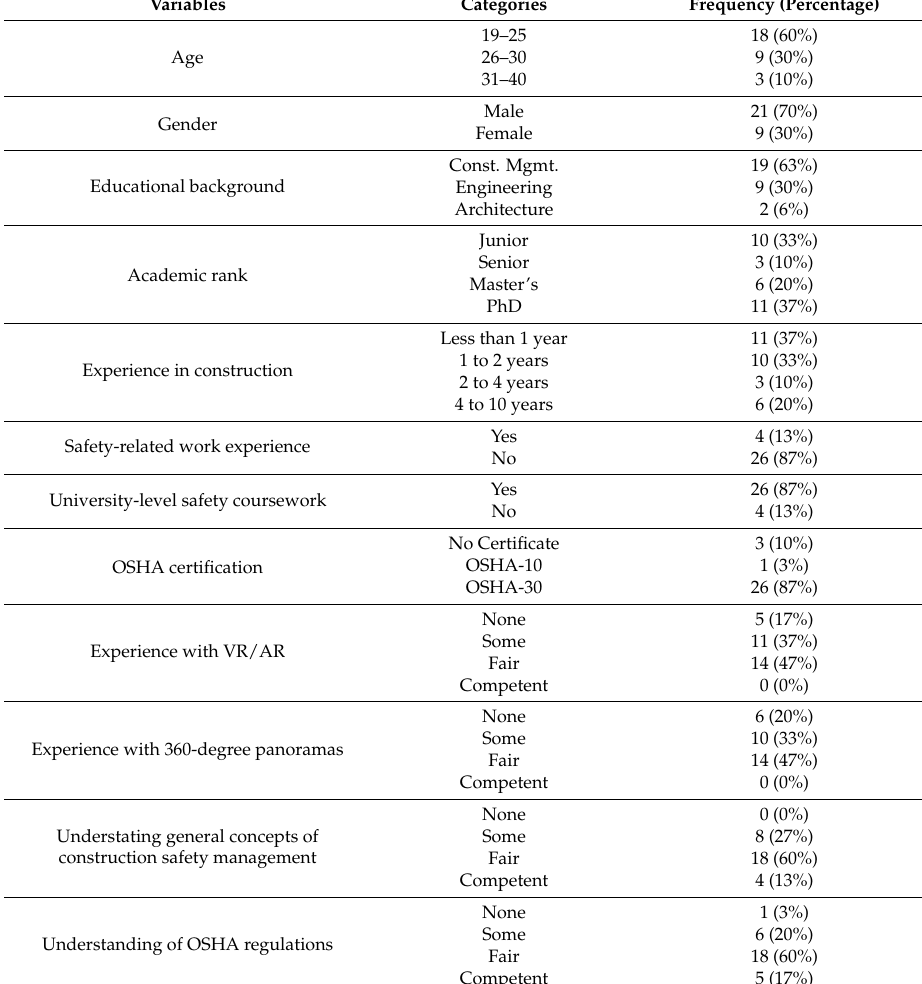
Table 3. Demographics of